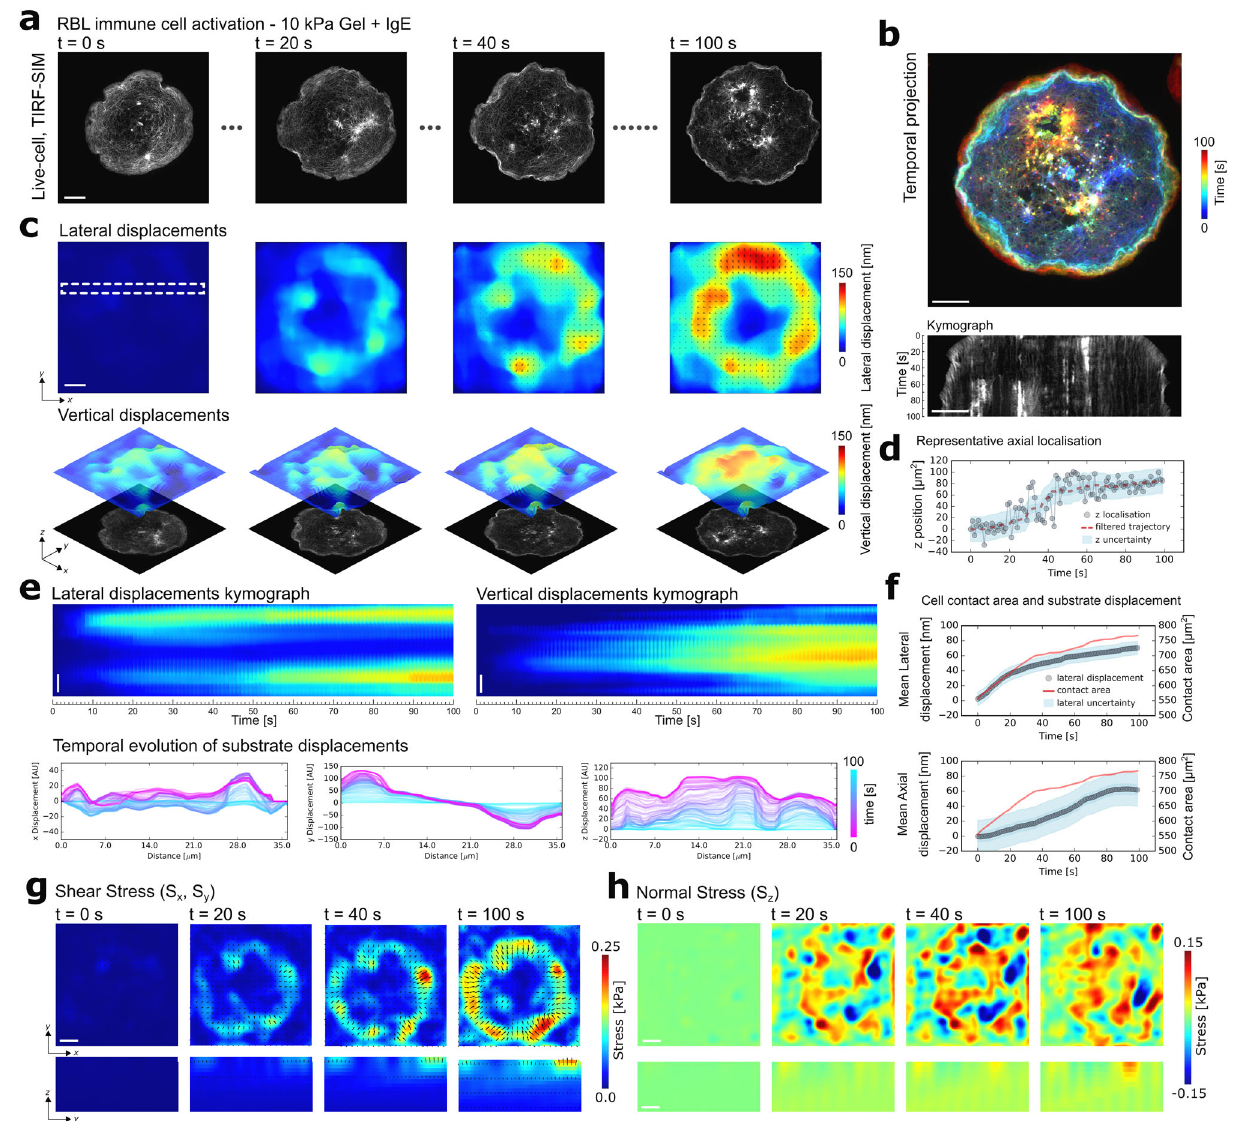
Fig. 3 Quantifying out-of-plane force generation during RBL immune cell activation using aTFM. a TIRF-SIM snap shots of an activating RBL cell over the course of the 100 s, 100 frame movie. Scale bar is 5 µ m. b Upper: Temporal projection of RBL cell during activation. Lower: Kymograph indicating the increase in contact area during RBL cell activation. Scale bar is 5 µ m. c Upper: Snap shots of the magnitude of lateral displacements resulting from RBL cell activation. Lower: Surface plots of the corresponding vertical displacement of the gel. The cell image is displayed below to facilitate correspondence of displacements with cellular structures. Scale bar is 5 µ m. d Plot showing the axial position of a representative raw bead trajectory (grey dots), as well as the fi ltered position (red) and displacement uncertainty as derived in Fig. 1c (blue region). e Both kymographs and line plots showing the continuous temporal evolution of the lateral and vertical surface displacements over the course of the recording. Scale bar is 5 µ m . f Plot showing the mean lateral and vertical gel displacements (grey dots) underlying the cell as a function of time during activation overlays with a quanti fi cation of cell contact area (red). The corresponding displacement uncertainty as derived in Fig. 1c is shown in blue. g Upper: Snap shots of the magnitude of shear stress resulting from RBL cell activation. Lower: Cross-section of the gel showing the distribution of shear stress through the bulk of the gel. Scale bar is 5 µ m. h Upper: Snap shots of the magnitude of normal stress at the gel surface. Lower: Cross-section of the gel showing the distribution of normal stress through the bulk of the gel. Scale bar is 5 µ